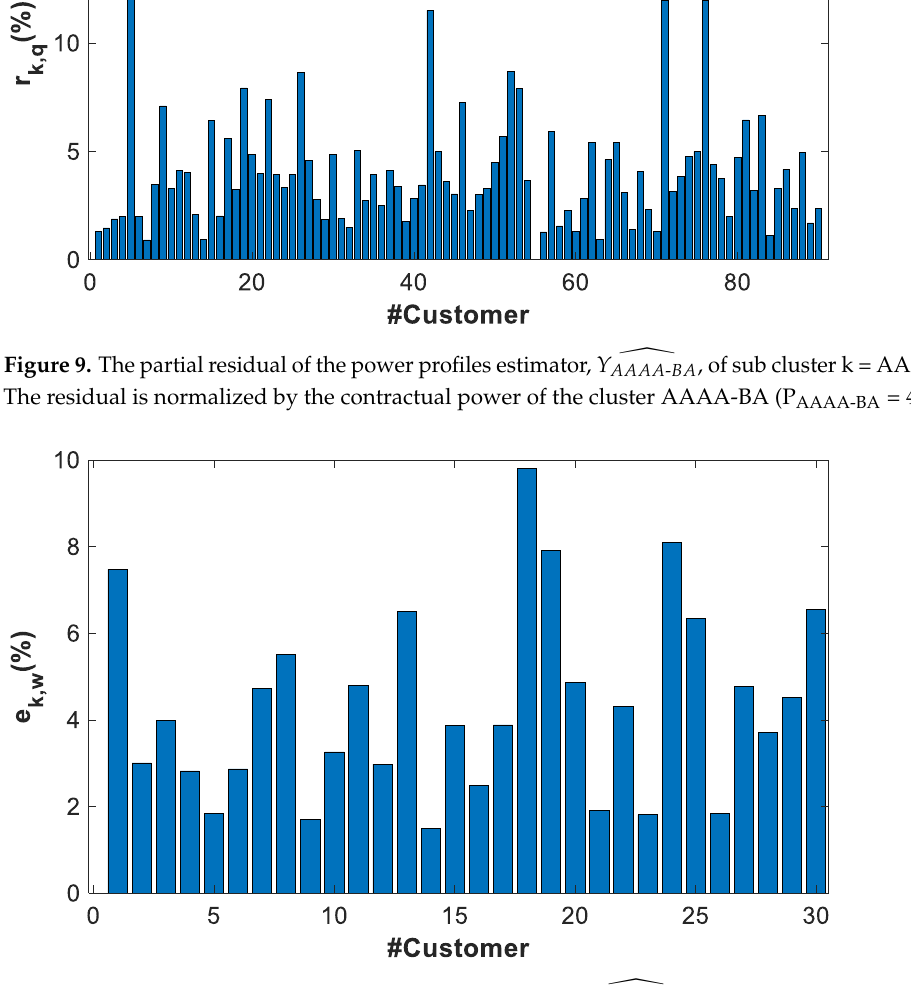
Figure 10. The partial error of the power profiles estimator, 𝑌 𝐴𝐴𝐴𝐴−𝐵𝐴 ̂ , of cluster k = AAAA-BA. The error is normalized by the contractual power of the cluster AAAA-BA (P AAAA-BA = 4 kW).